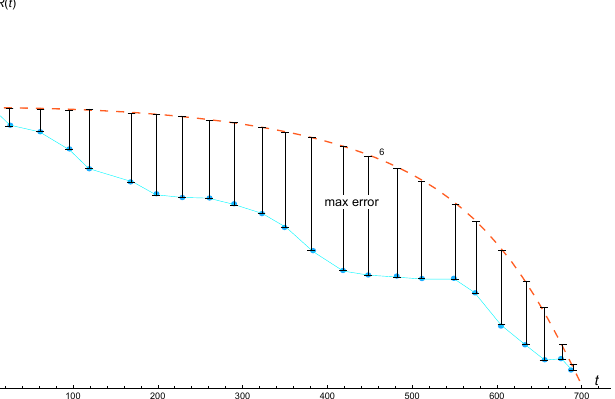
Figure 8. Comparison of results between the solution profile of the mathematical model with the standard protocol and clinical data. The dashed line represents the plot obtained from the mathematical model (see plot number 6 from Figure 7) and the dot plot represents the clinical data obtained from the open access data: https://www.clinicaltrials.gov/, accessed on 25 September